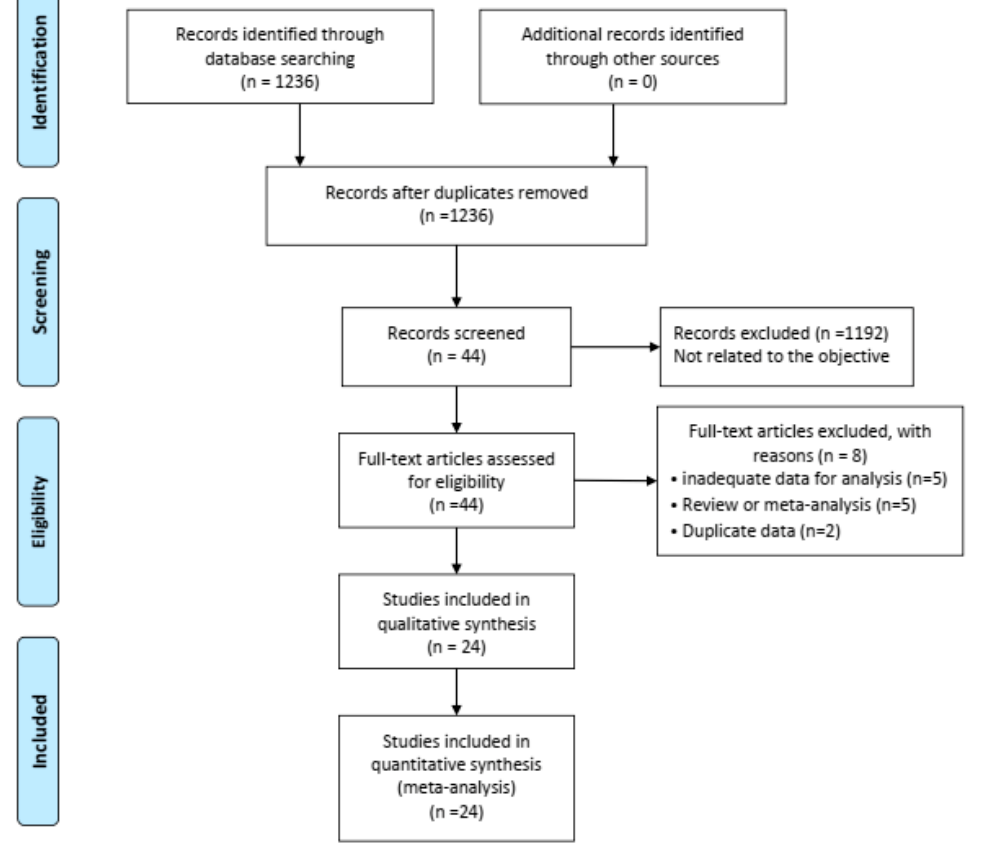
Figure 1. Flowchart of study identification and selection.